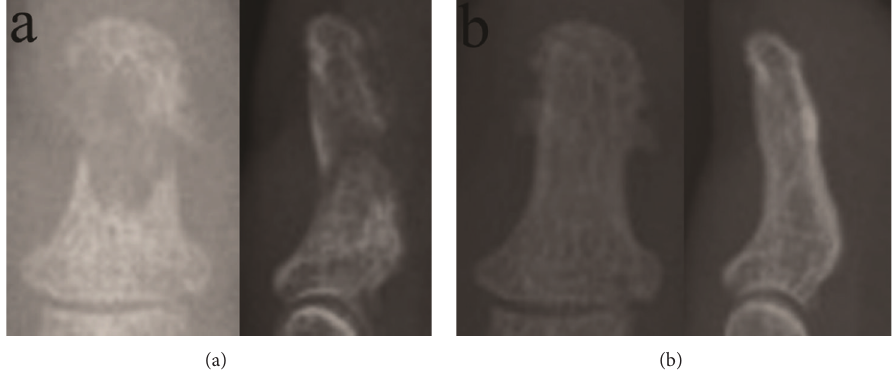
Figure 5: Anteroposterior and lateral radiographs at 1 month (a) and 10 months (b) after surgery.